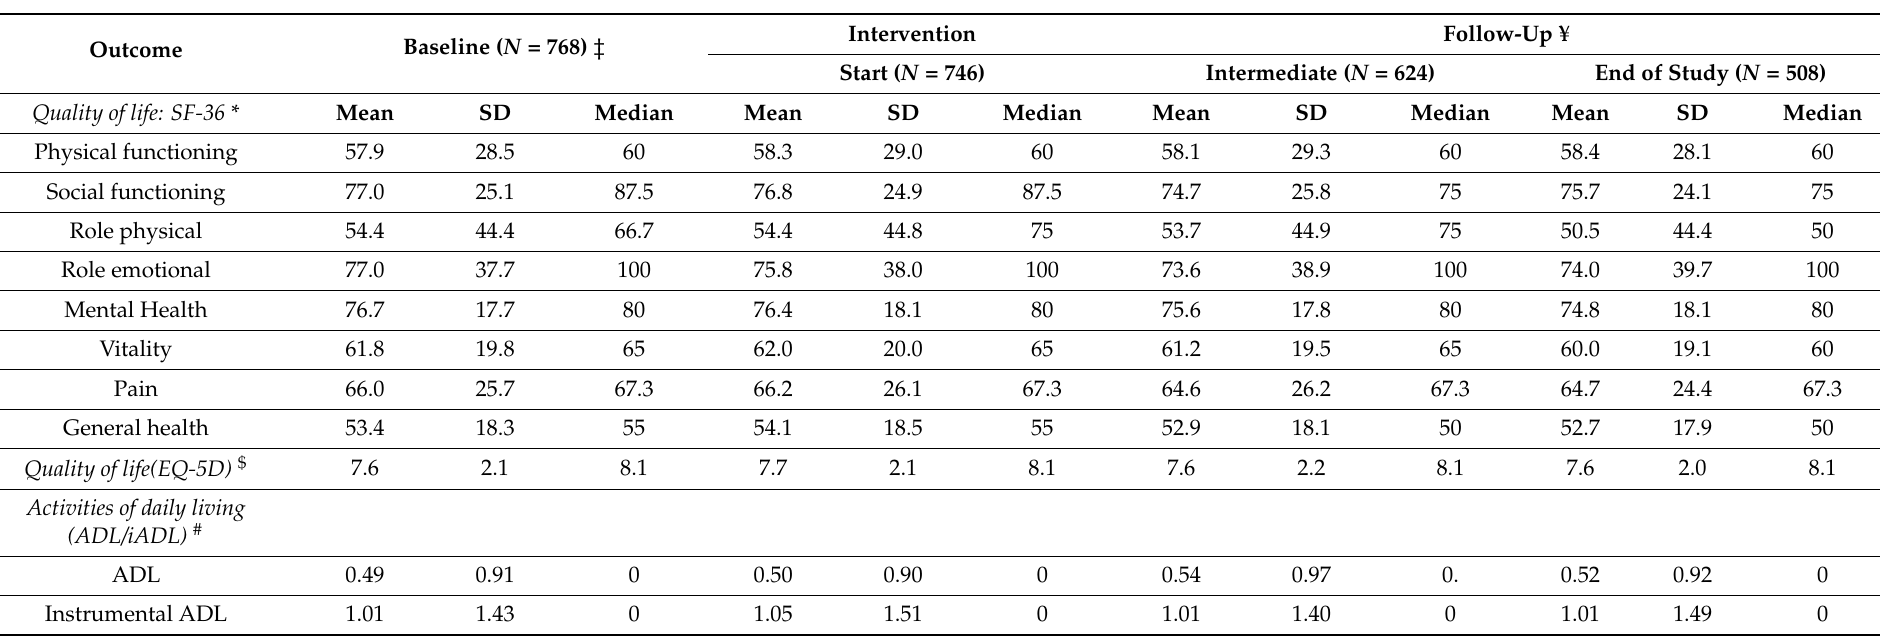
Table 3. Patients’ quality of life (SF-36 and EQ-5D) activities of daily living (ADL) and instrumental ADL, at baseline, start of the intervention, intermediate follow-up and end of study. Intervention Follow-Up ¥ Outcome Baseline ( N = 768) ‡ Start ( N = 746) Intermediate ( N = 624) End of Study ( N = 508) Quality of life: SF-36 * Mean